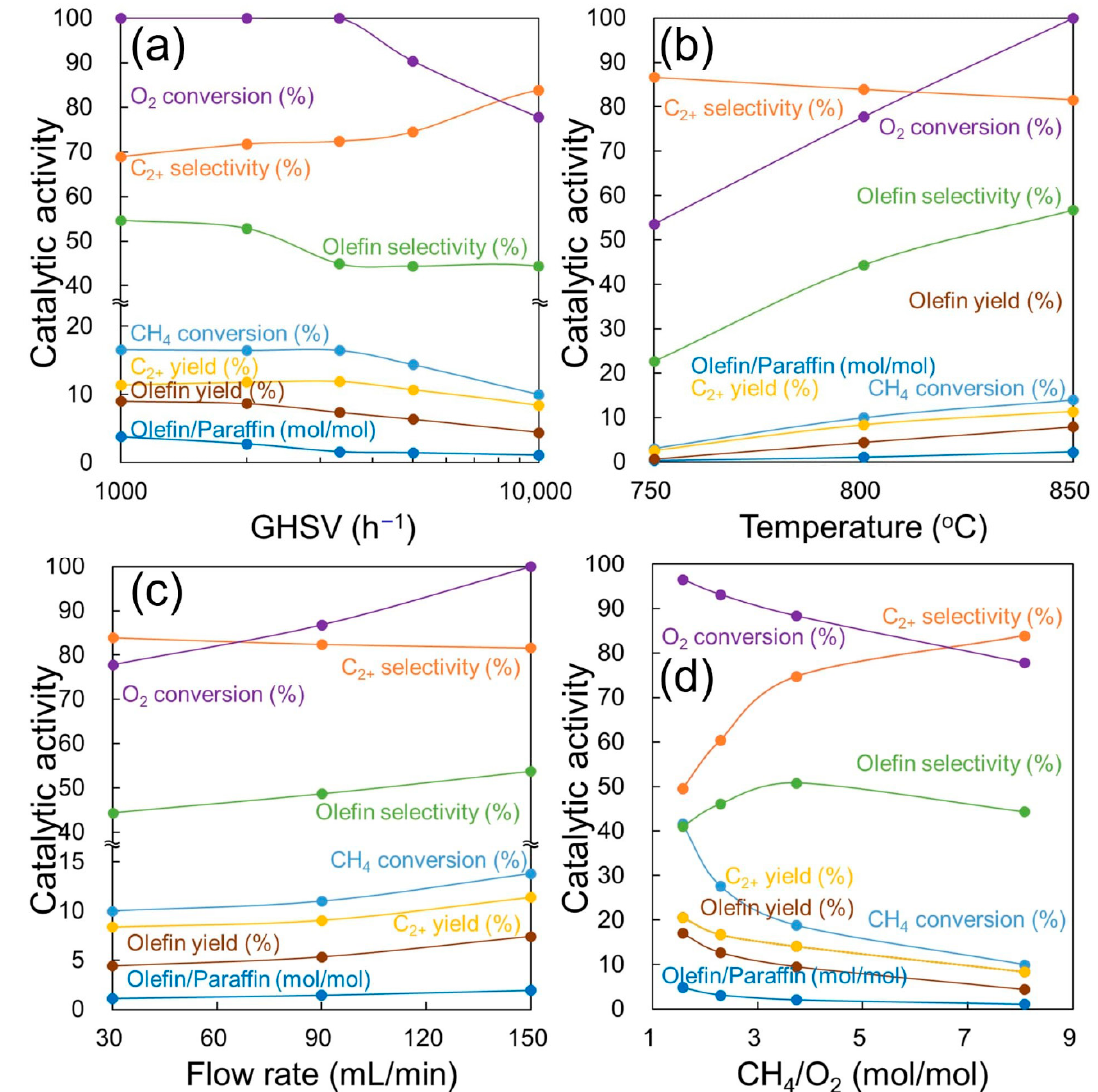
Figure 7. Oxidative coupling of methane results depending on ( a ) gas hourly space velocity (GHSV), ( b ) reaction temperature, ( c ) flow rate, and ( d ) CH 4 /O 2 ratio. Reaction conditions: ( a ) 800 °C, 30 mL/min of flow rate, and CH 4 /O 2 /N 2 /CO 2 /H 2 S = 16.1/2/1/10.7/0.1 (v/v/v/v/v). ( b ) GHSV = 10,000 h − 1 , 0.18 mL of catalyst, 30 mL/min of flow rate, and CH 4 /O 2 /N 2 /CO 2 /H 2 S = 16.1/2/1/10.7/0.1 (v/v/v/v/v). ( c ) GHSV = 10,000 h − 1 , 0.18 mL of catalyst, 800 °C, and CH 4 /O 2 /N 2 /CO 2 /H 2 S = 16.1/2/1/10.7/0.1 (v/v/v/v/v). ( d ) GHSV = 10,000 h − 1 , 0.18 mL of catalyst, 800 °C, 30 mL/min of flow rate, and (a mixture of CH 4 , CO 2 , H 2 S, and O 2 )/N 2 = 29/1 (v/v).